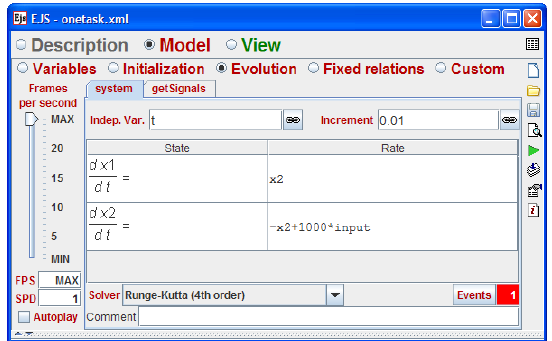
Figure 6. Ordinary differential equations of the model system using the editor of EJS. The ODE models are defined in the section Evolution in